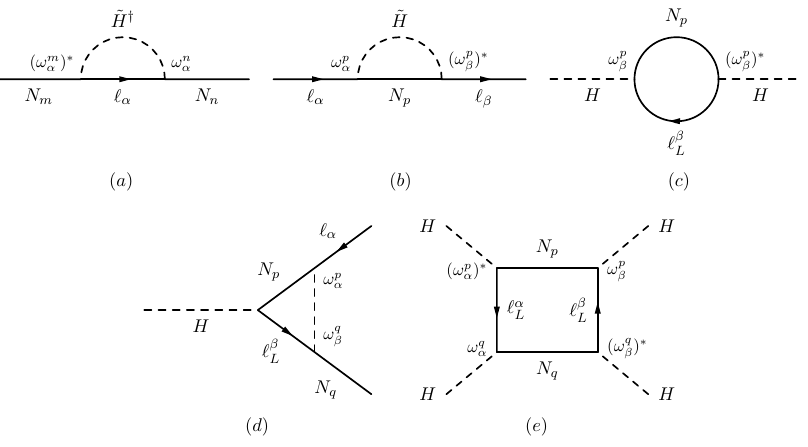
Figure 1 . One loop matching diagrams for the seesaw